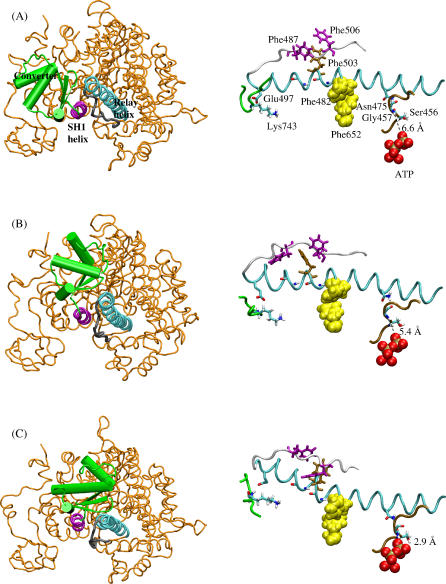
Three Snapshots (at 0.0 ps, 630.0 ps, and 1270.0 ps) from One of the Three TMD Simulations, in the Same Format as Figure 2 in [31] for Comparison(Left) The converter domain rotation, viewed from the C-terminus of the relay helix and down the axis of the SH1 helix, whose axis is similar to the converter-rotation axis.(Right) The proposed coupling between the small motion of the Switch II with the large translation of the helix C-terminus along the relay helix.